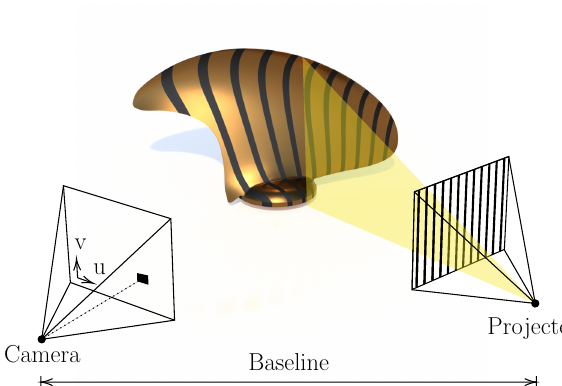
Figure 2: Working principle of structured light-based 3D